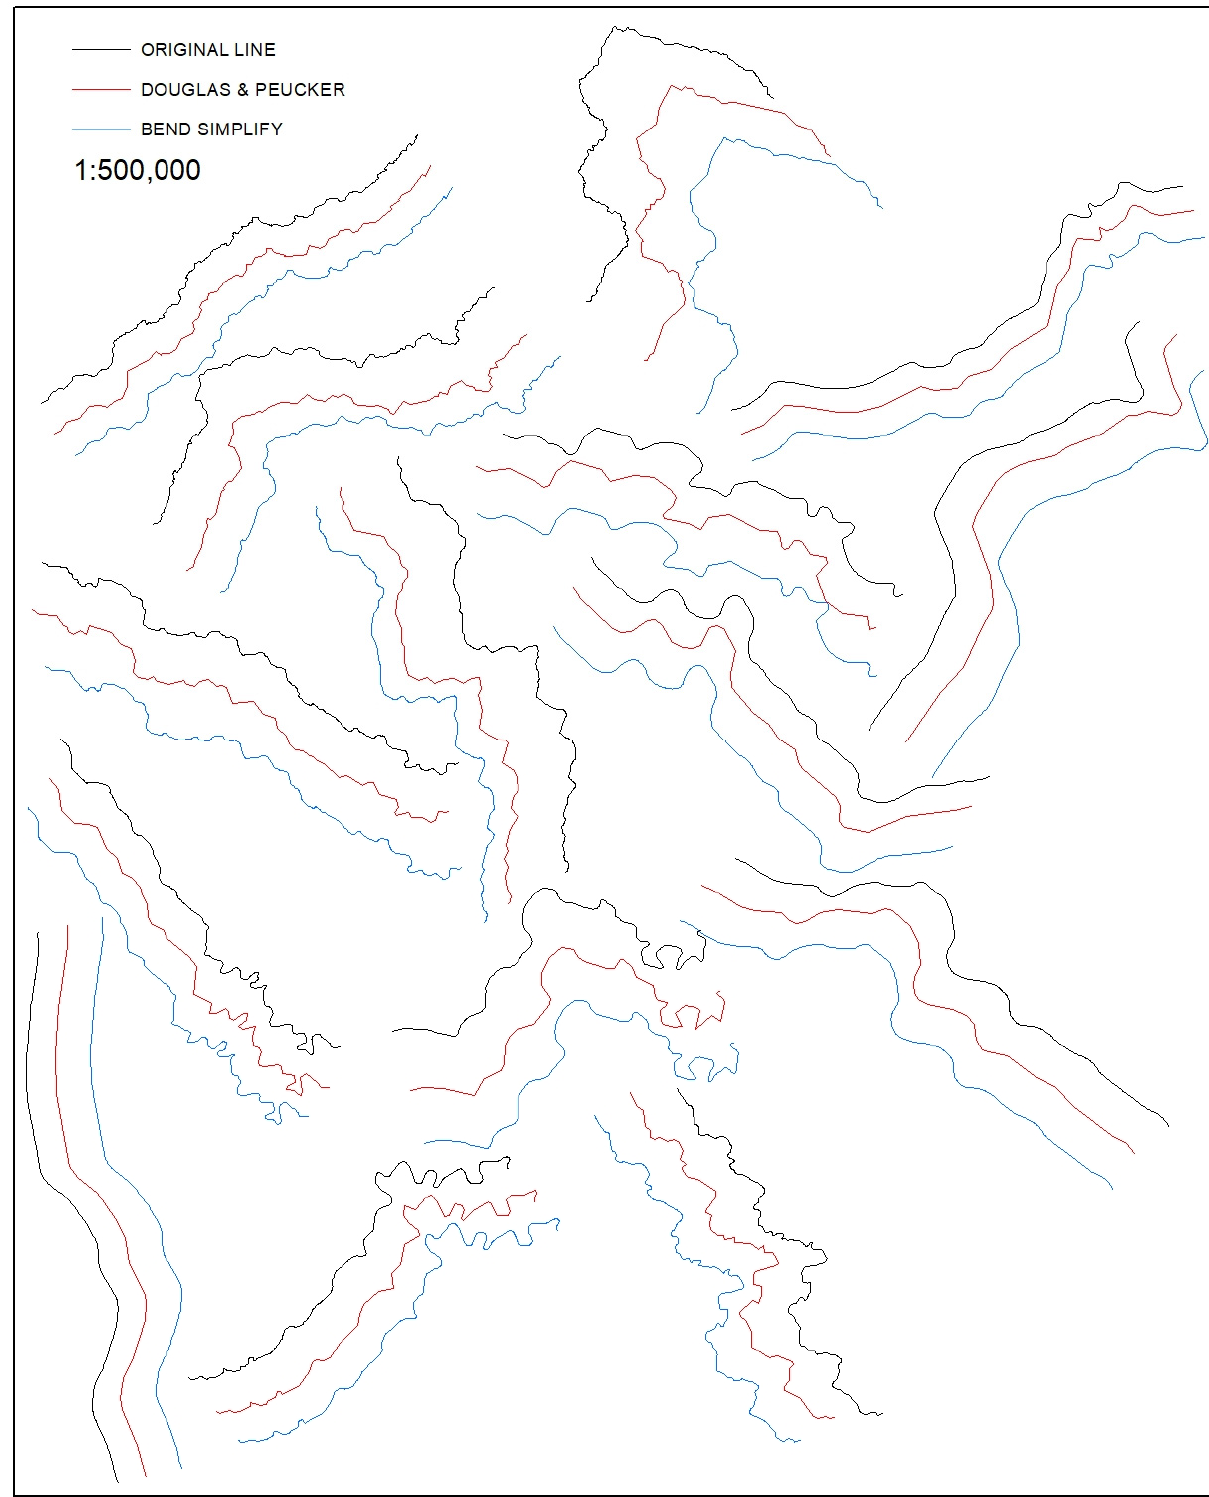
Figure 5. Line features generalized with the Douglas–Peucker simplification algorithm (red) and bend simplification algorithm (blue). Original lines are depicted in black (scale